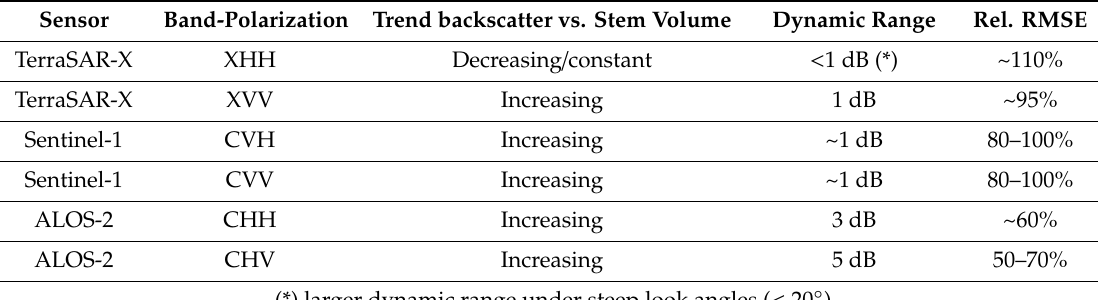
Table 5. Multi-temporal characteristics of the relationship between SAR backscatter and stem volume at Krycklan for a given frequency band and polarization. Sensor Band-Polarization Trend backscatter vs. Stem Volume Dynamic Range Rel. RMSE TerraSAR-X XHH Decreasing / constant < 1 dB (*) ~110% TerraSAR-X XVV Increasing 1 dB ~95% Sentinel-1 CVH Increasing ~1 dB 80–100% Sentinel-1